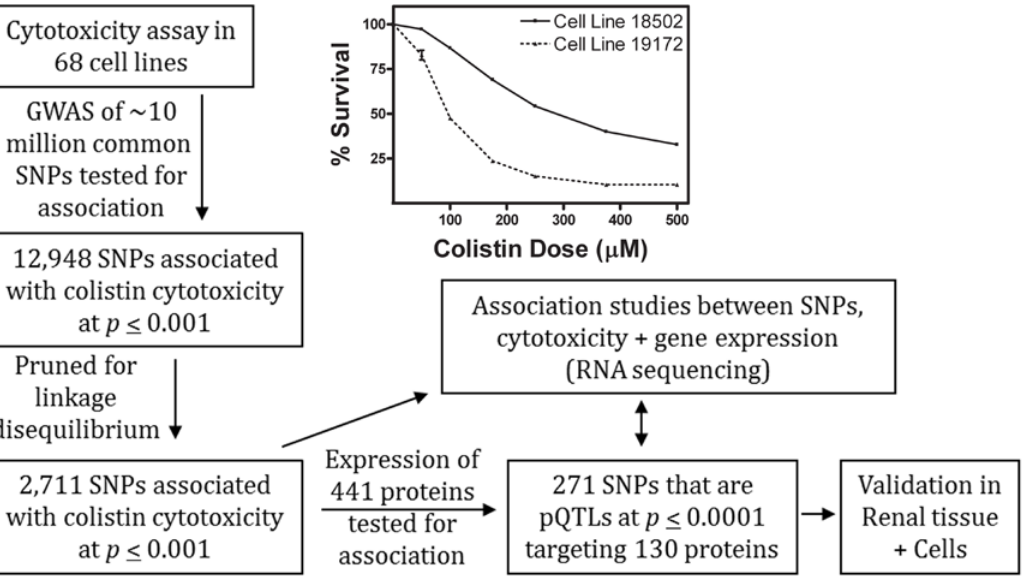
Figure 1. Schematic diagram of experimentation and analyses. Association studies were performed in 68 Yoruban (YRI) cells using 10 million single nucleotide polymorphisms (SNPs) (imputed), baseline gene expression measured by RNA sequencing (RNAseq), and baseline protein expression measured by microwestern and reverse phase protein arrays. Given the pertinence of colistin toxicity to human kidney injury, associations were then validated in human renal proximal tubular cells. GWAS: Genome-wide association study; pQTLs: Protein quantitative trait loci.